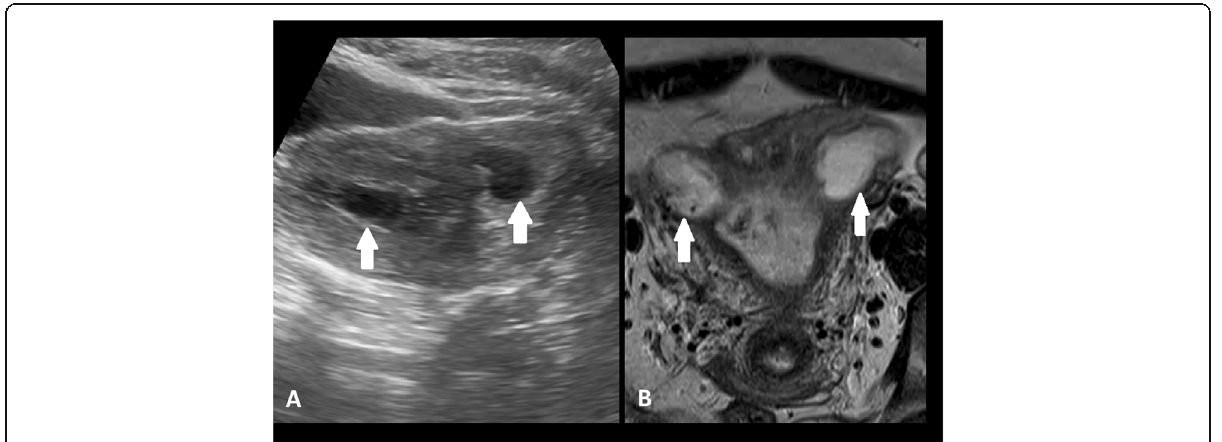
Fig. 1 a USG image showing two gestational sacs, one in each cornu of the uterus, suggesting the presence of interstitial/ angular pregnancy. b T2-weighted coronal image shows two gestational sacs, one in each cornu (arrow), lateral to the uterotubal junctions suggesting bilateral interstitial